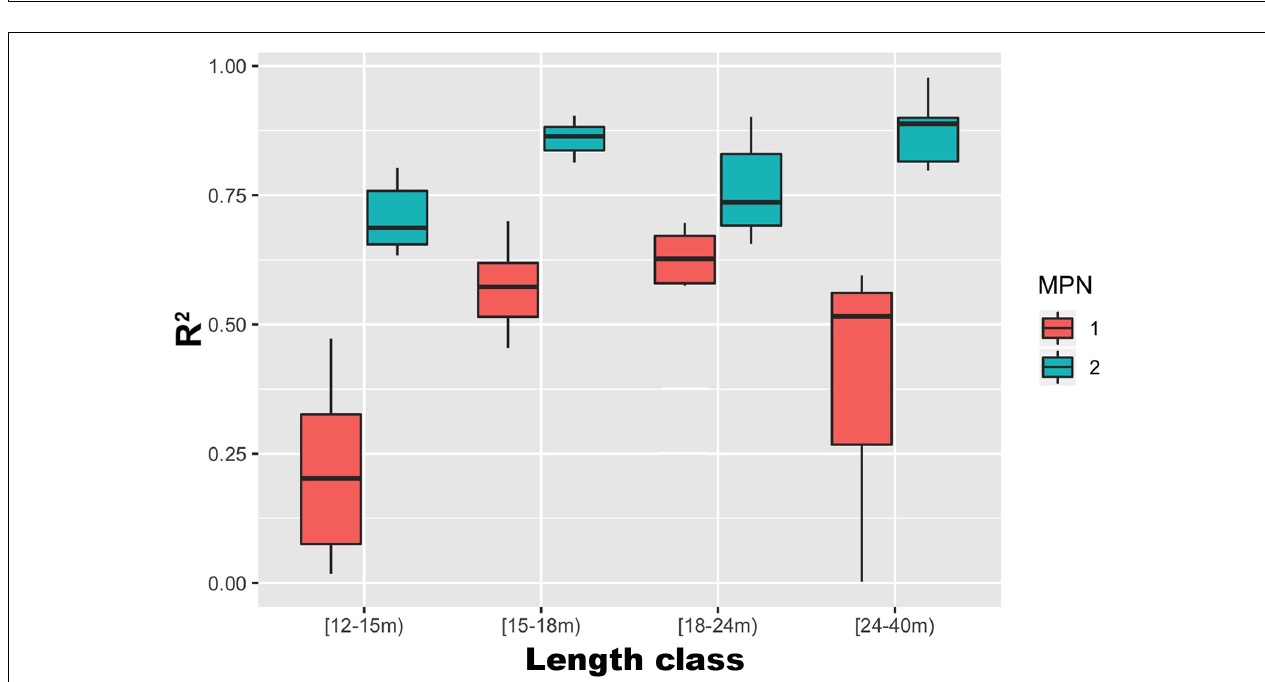
FIGURE 8 | Boxplots of the MPN1 (red) and MPN2 (blue) performances ( R 2 between predicted and observed fishing efforts for the test datasets, using 100 random repetitions) of the CMPN 10 − 8 (the CMPN with 10 neurons in the hidden stratum of MPN1 and 8 neurons in the hidden stratum of MPN2, which scored as the best architecture). Boxes and whiskers showing the medians (thick lines), 25th and 75th quantiles (lower and upper margin of the boxes) and ranges (vertical lines) of